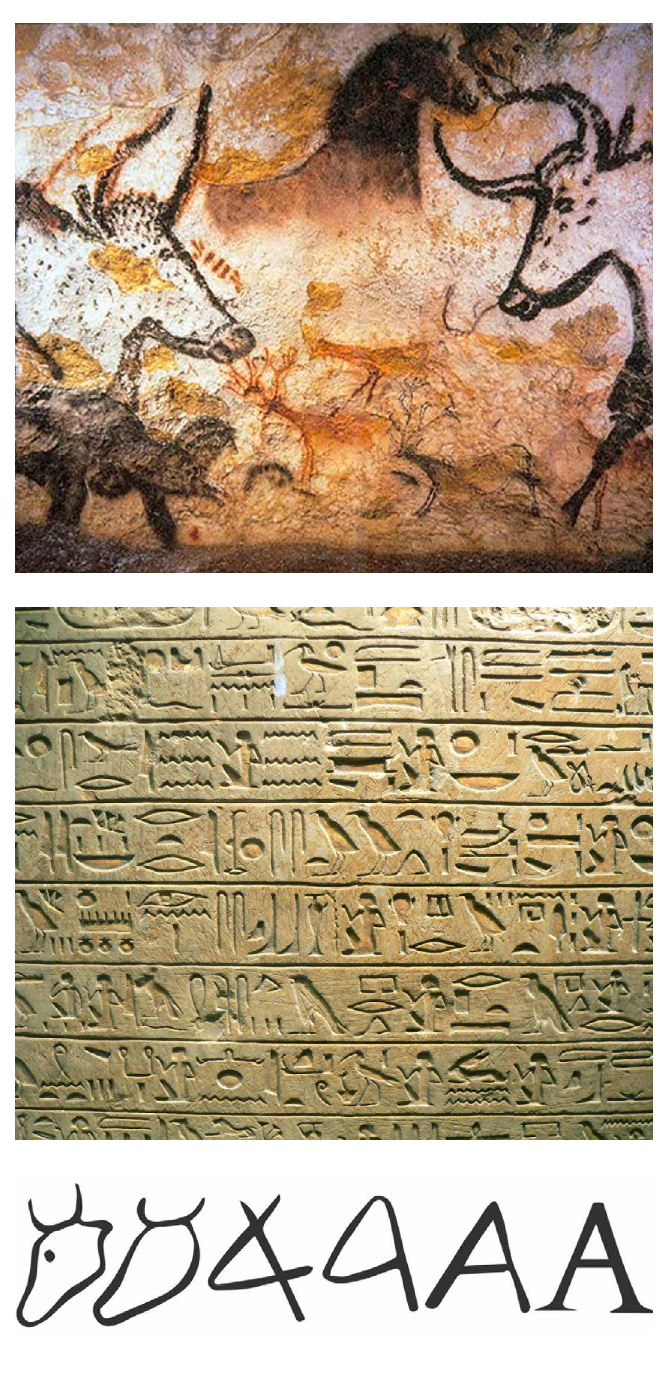
to represent the sound 'A'.